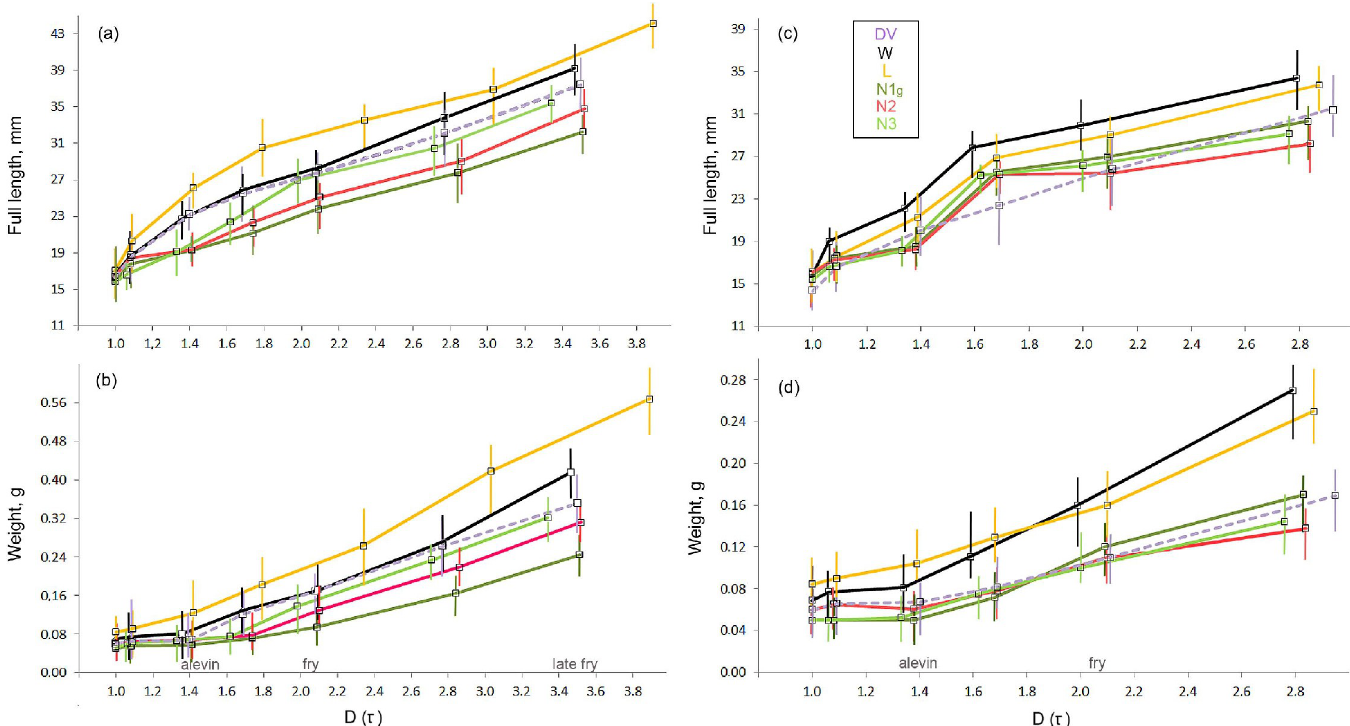
Fig 3. Postnatal somatic growth of the Lake Kronotskoe charr morphs and Dolly Varden reared under the natural ( a , b ) and standard ( c , d ) temperatures. Mean and min- max values are presented; the morphs are shown in different colors.